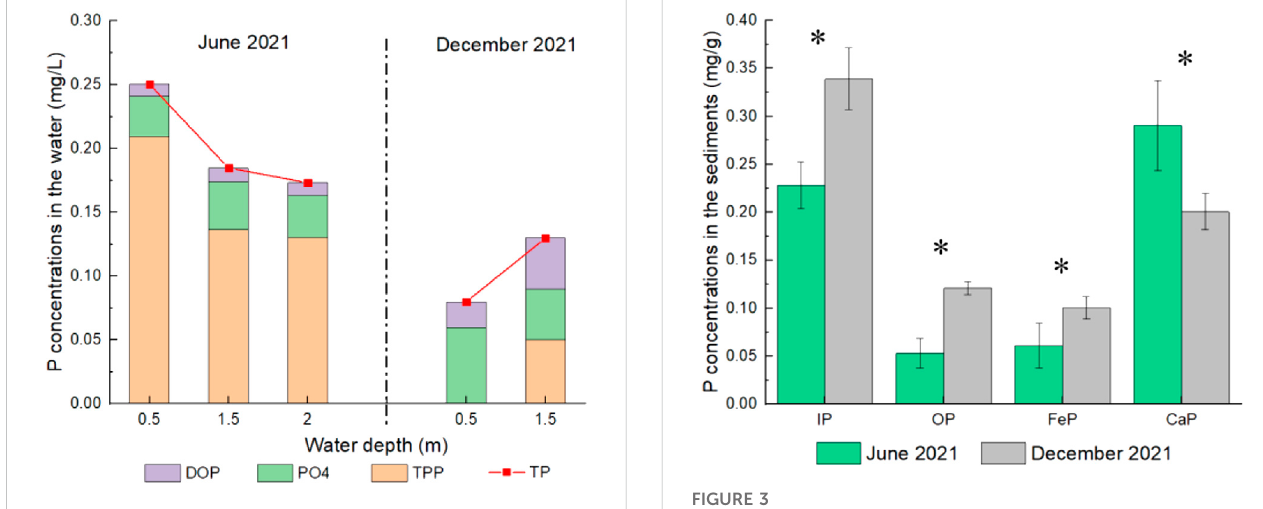
FIGURE 2 Concentrations of P forms in the water in the two periods.